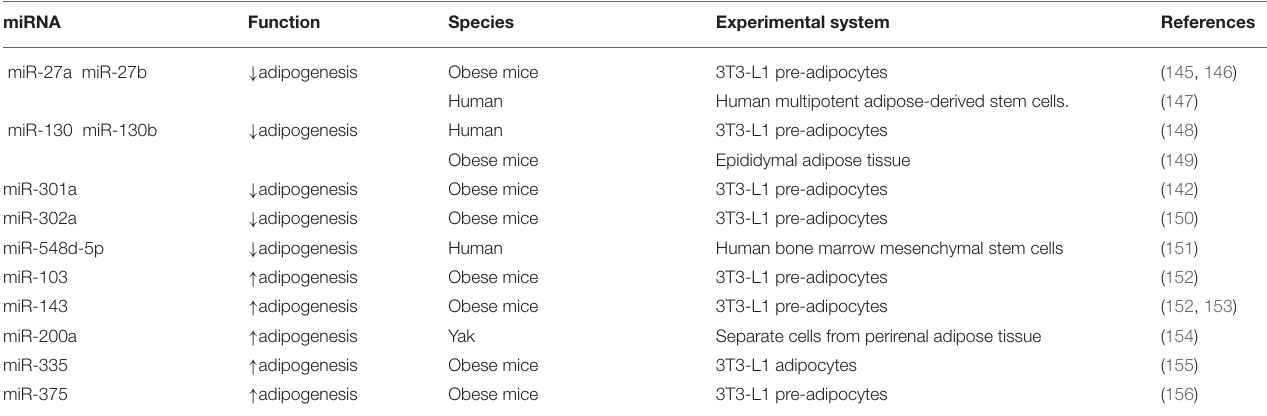
TABLE 1 | Regulation of PPAR γ by miRNAs during adipogenesis and obesity.